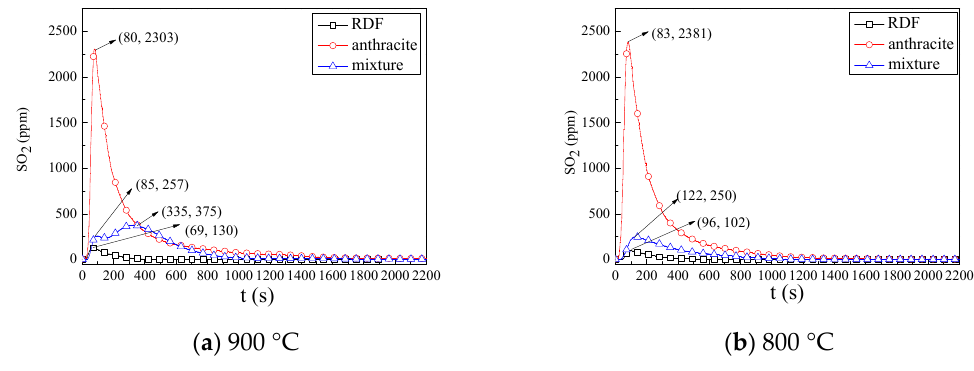
Figure 8. SO 2 emission curves at different temperatures.